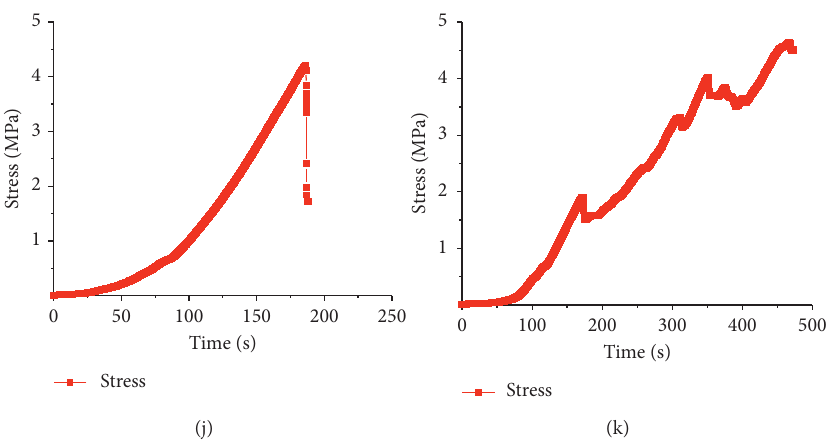
Figure 5: Deep tight sandstone tensile - compressive stress - strain curve. (a) S1-1. (b) S1-2. (c) S1-3. (d) S1-4. (e) S1-5. (f) S1-6. (g) S1-7. (h)